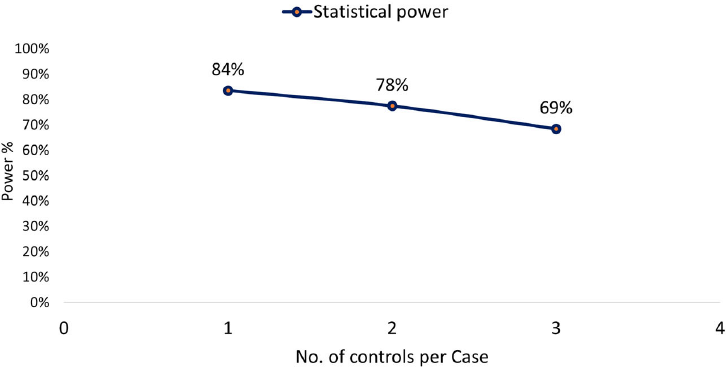
Figure 1. Relationship between number of controls per case and statistical power.